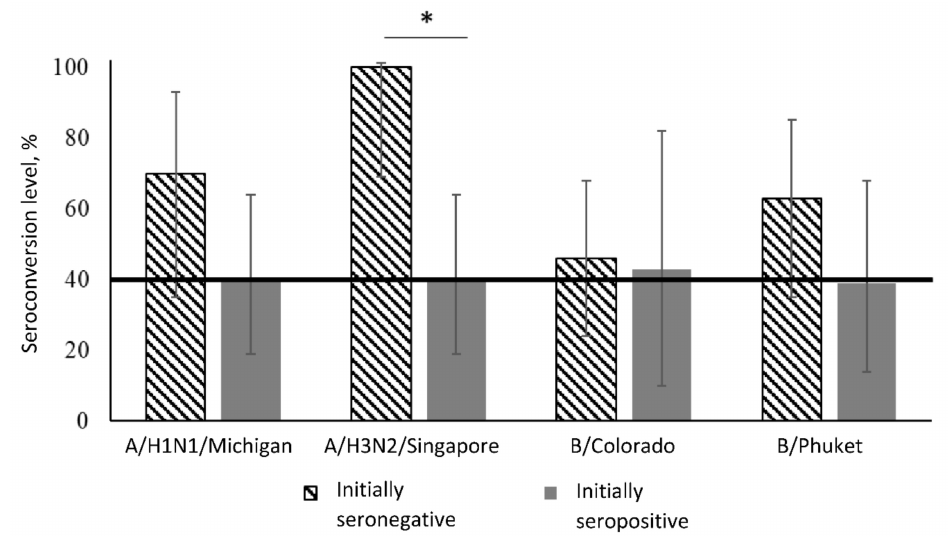
Figure 2. Seroconversion level 3 weeks after immunization given the initial level of antibodies in the group of healthy participants. Notes: *—statistically significant di ff erences between groups.